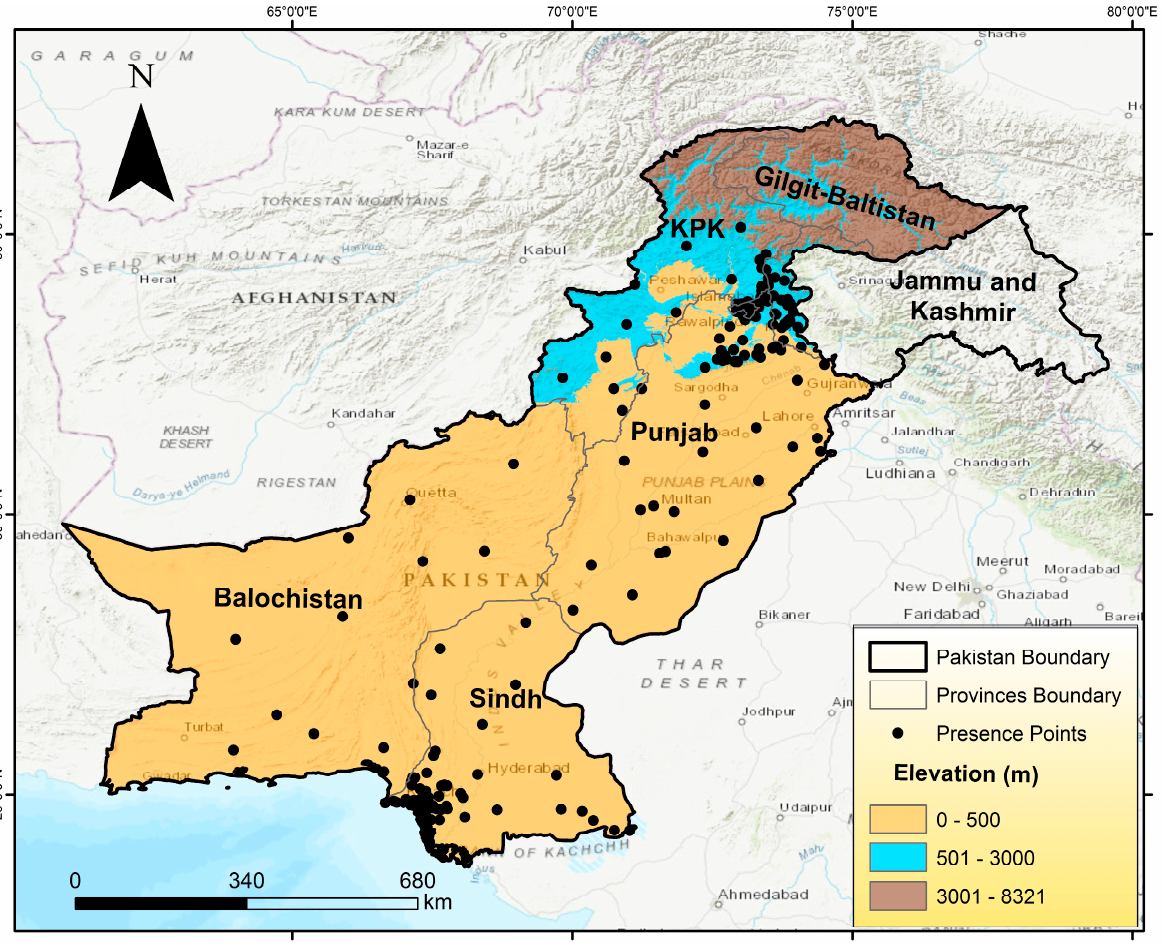
Figure 1. Presence-only data records of steppe eagles in Pakistan obtained from different sources, explained in the Section